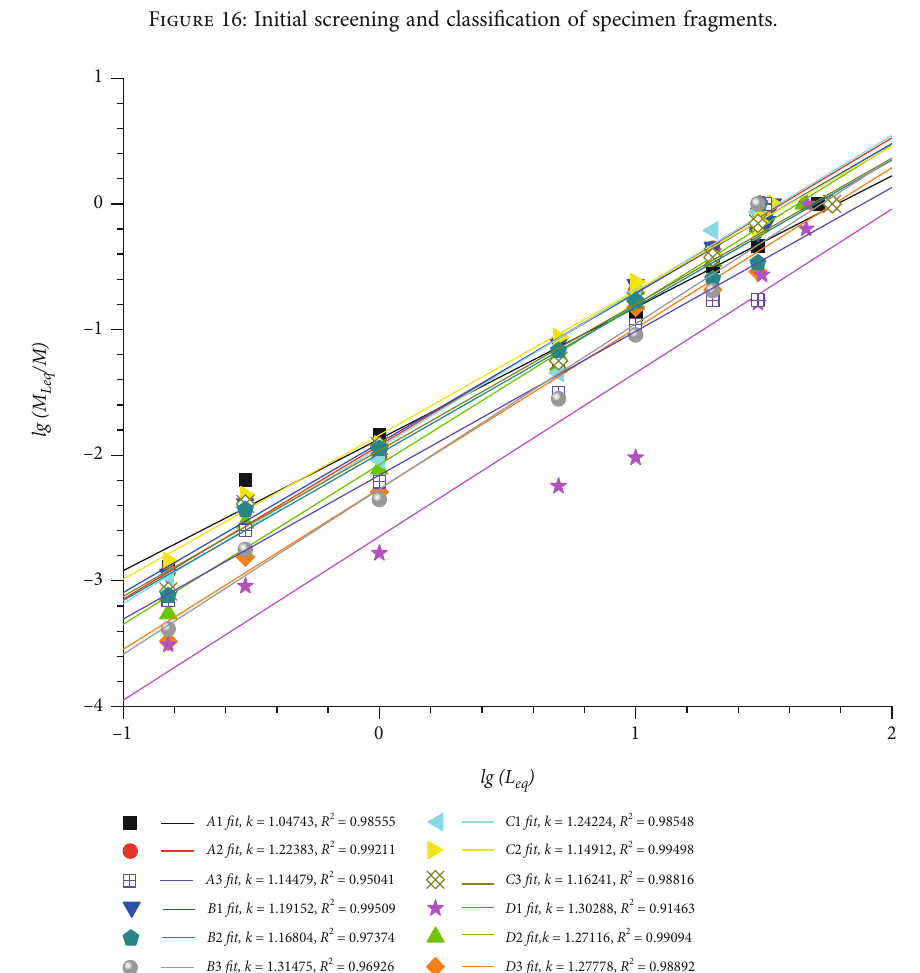
Figure 17: Logarithmic plot of equivalent length quality of coal sample